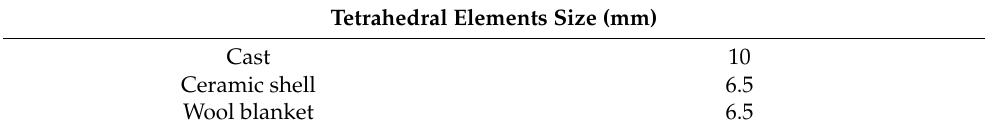
Table 1. Element size distribution.